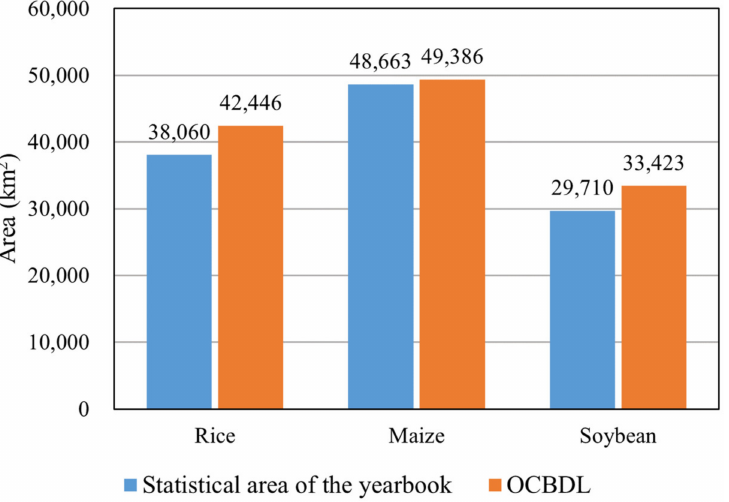
Figure 14. Crop areas recorded in the Statistical Yearbook for 11 cities in Heilongjiang Province in 2020 and the crop areas extracted by